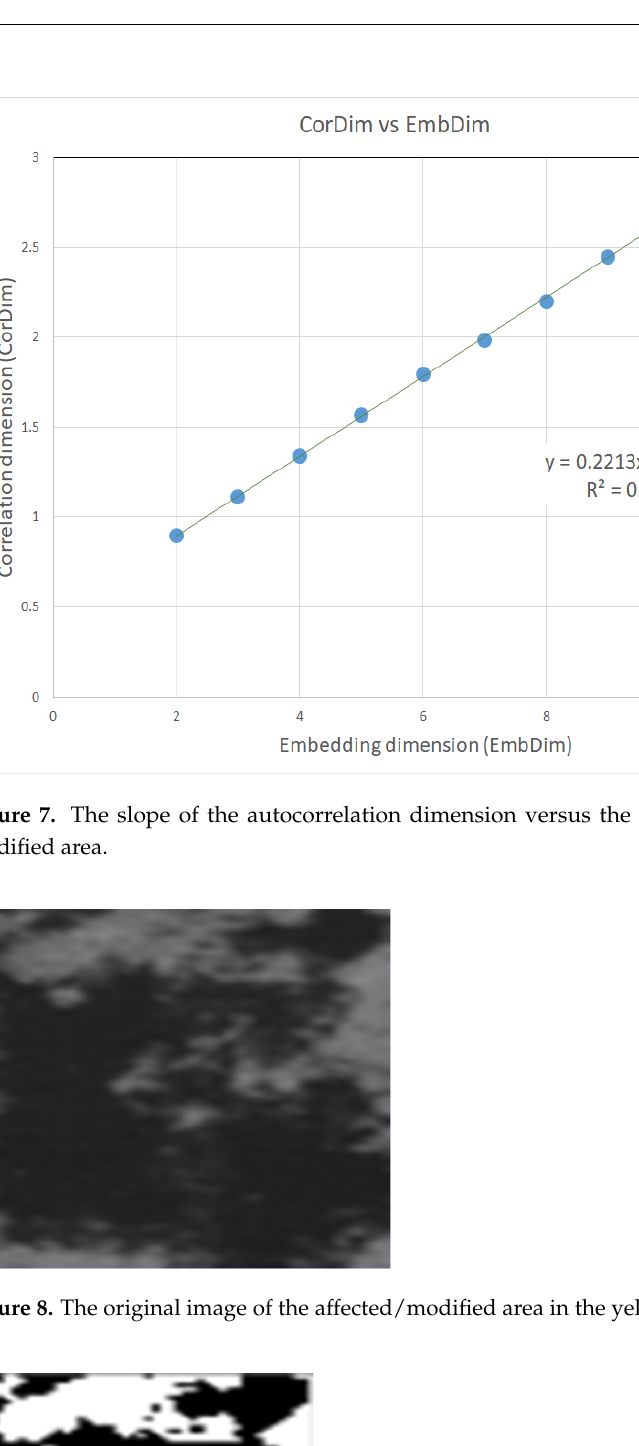
Figure 8. The original image of the affected/modified area in the yellow border.